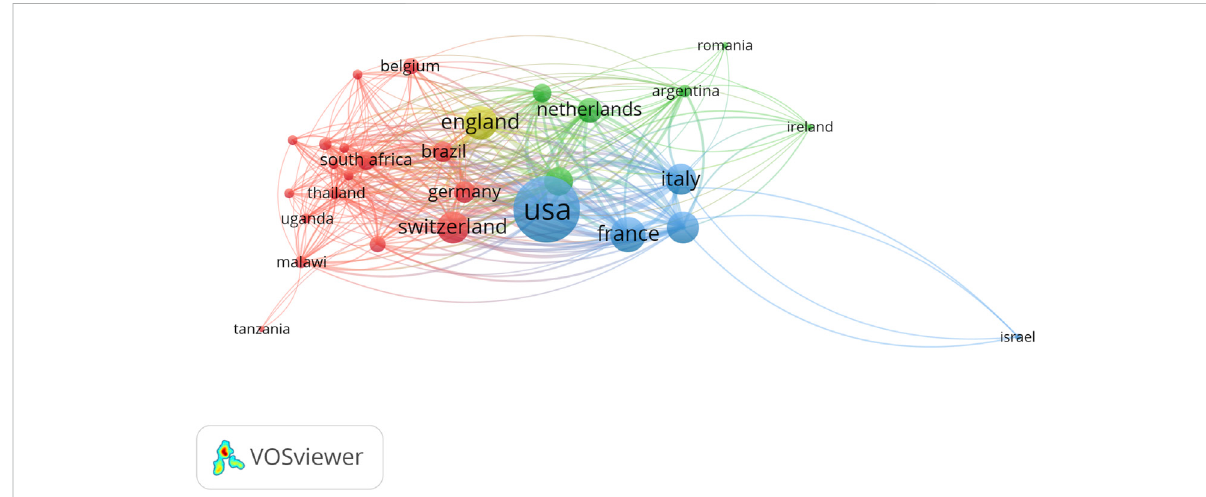
FIGURE 1 Cooperation of different countries.